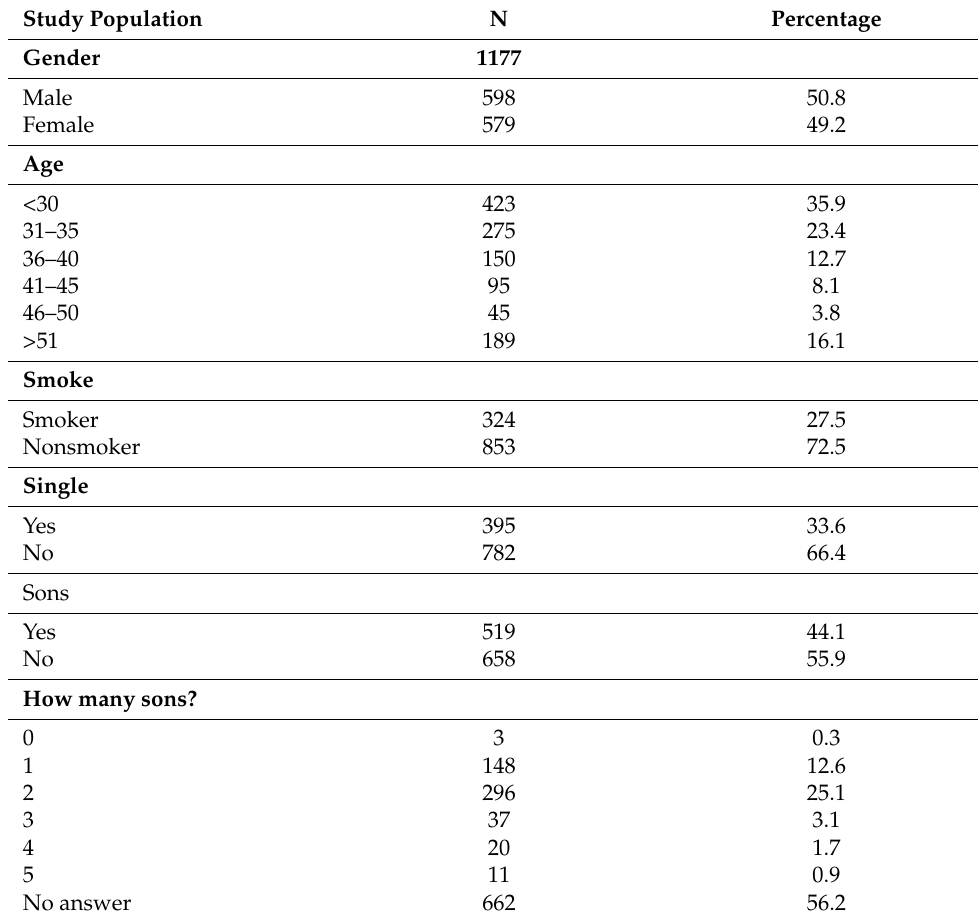
Table 1. Study population characteristics.